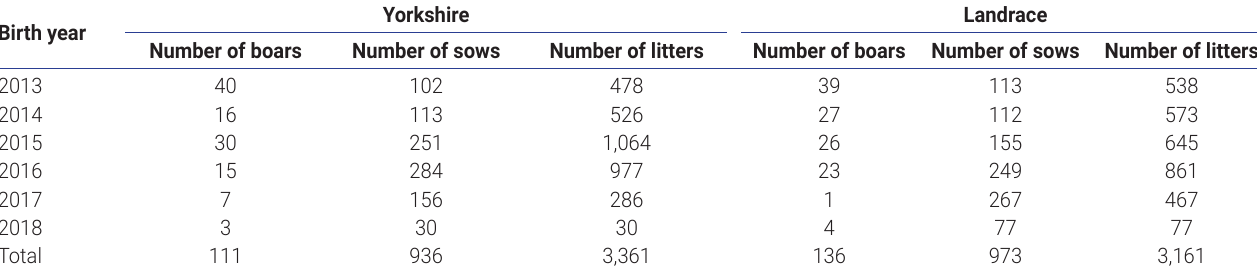
Table 1. Structure of data collected for the genetic analysis of Danish Yorkshire and Landrace pigs Yorkshire Landrace Birth year Number of boars Number of sows Number of litters Number of